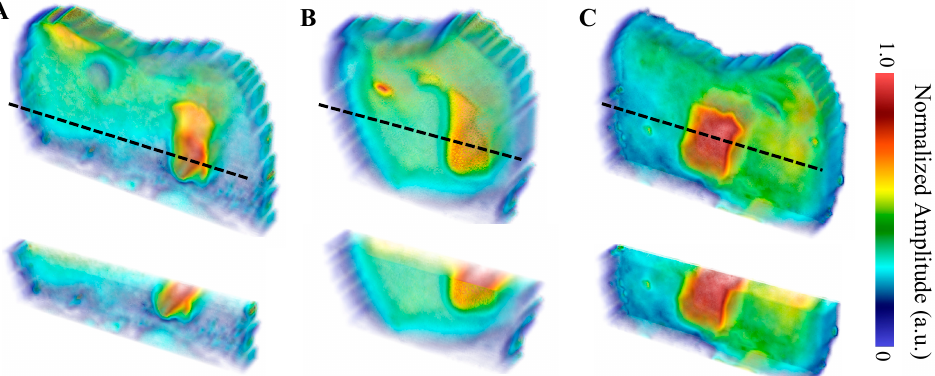
Figure 6. eTC-PCT amplitude reconstructions with partial transparency of the ( A ) buccal, ( B ) distal, and ( C ) lingual surfaces using a 0.2–0.6 Hz, 12 s chirp with 40 ms pulse width and 20 ms slice width for reconstructions. The dashed black lines indicate the regions where the cross-sectional cuts (displayed underneath the whole volume) were made. The reconstructions were generated by linearly rescaling each tomographic slice between (0,1) and stacking the layers. Volumes are displayed using software available online [31].